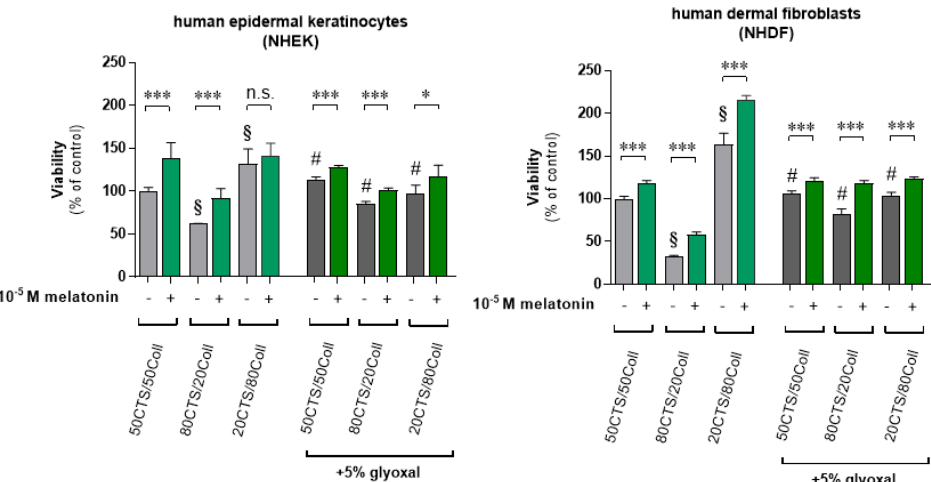
Figure 4. Human epidermal keratinocytes (NHEK) and human dermal fibroblasts (NHDF) were seeded on CTS/Coll scaffolds alone or containing 5% glyoxal in comparison to the culture medium including 10 − 5 M melatonin, cultured for 96 h, and viability was assessed using the MTT assay as described in Materials and Methods. Data are presented as mean + S.D. ( n = 6), expressed as a percentage of the control sample (cells cultured on scaffolds without glyoxal and without melatonin). Statistically significant differences were indicated as follows; § p < 0.01: vs. 50CTS/50Coll sample, # p < 0.01: comparison of the corresponding samples containing 5% glyoxal and scaffolds alone, and corresponding statistical comparison as * p < 0.05, *** p < 0.001, n.s.-not significant.